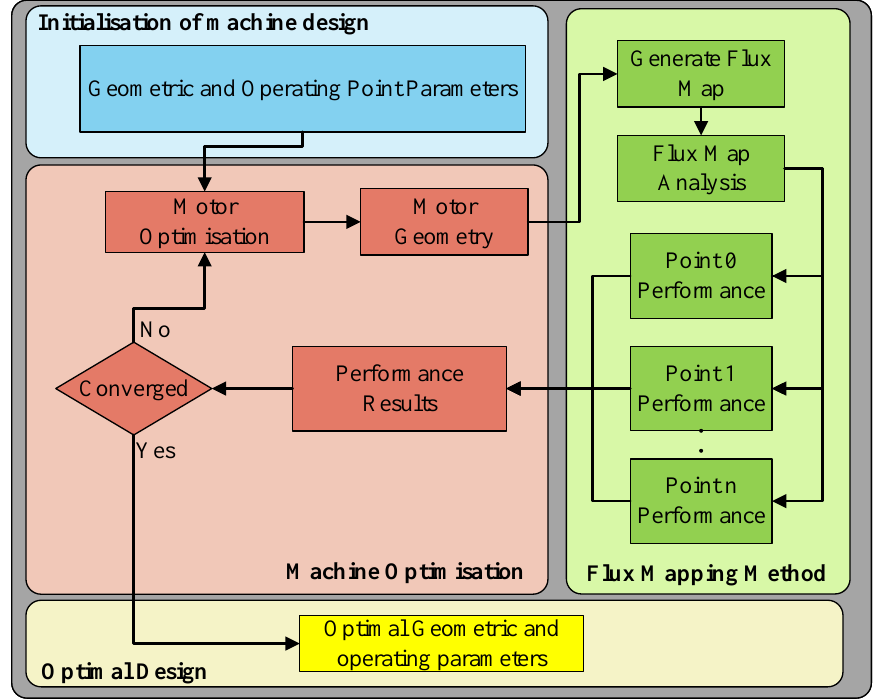
Figure 9. Flux mapping optimisation flow chart.